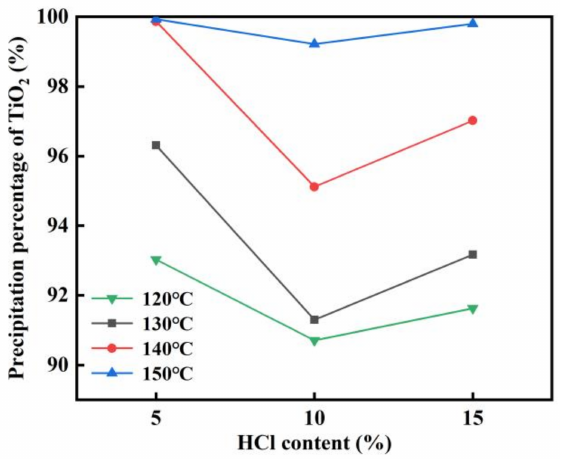
Figure 5. Effects of added HCl on the hydrothermal precipitation extent of TiO